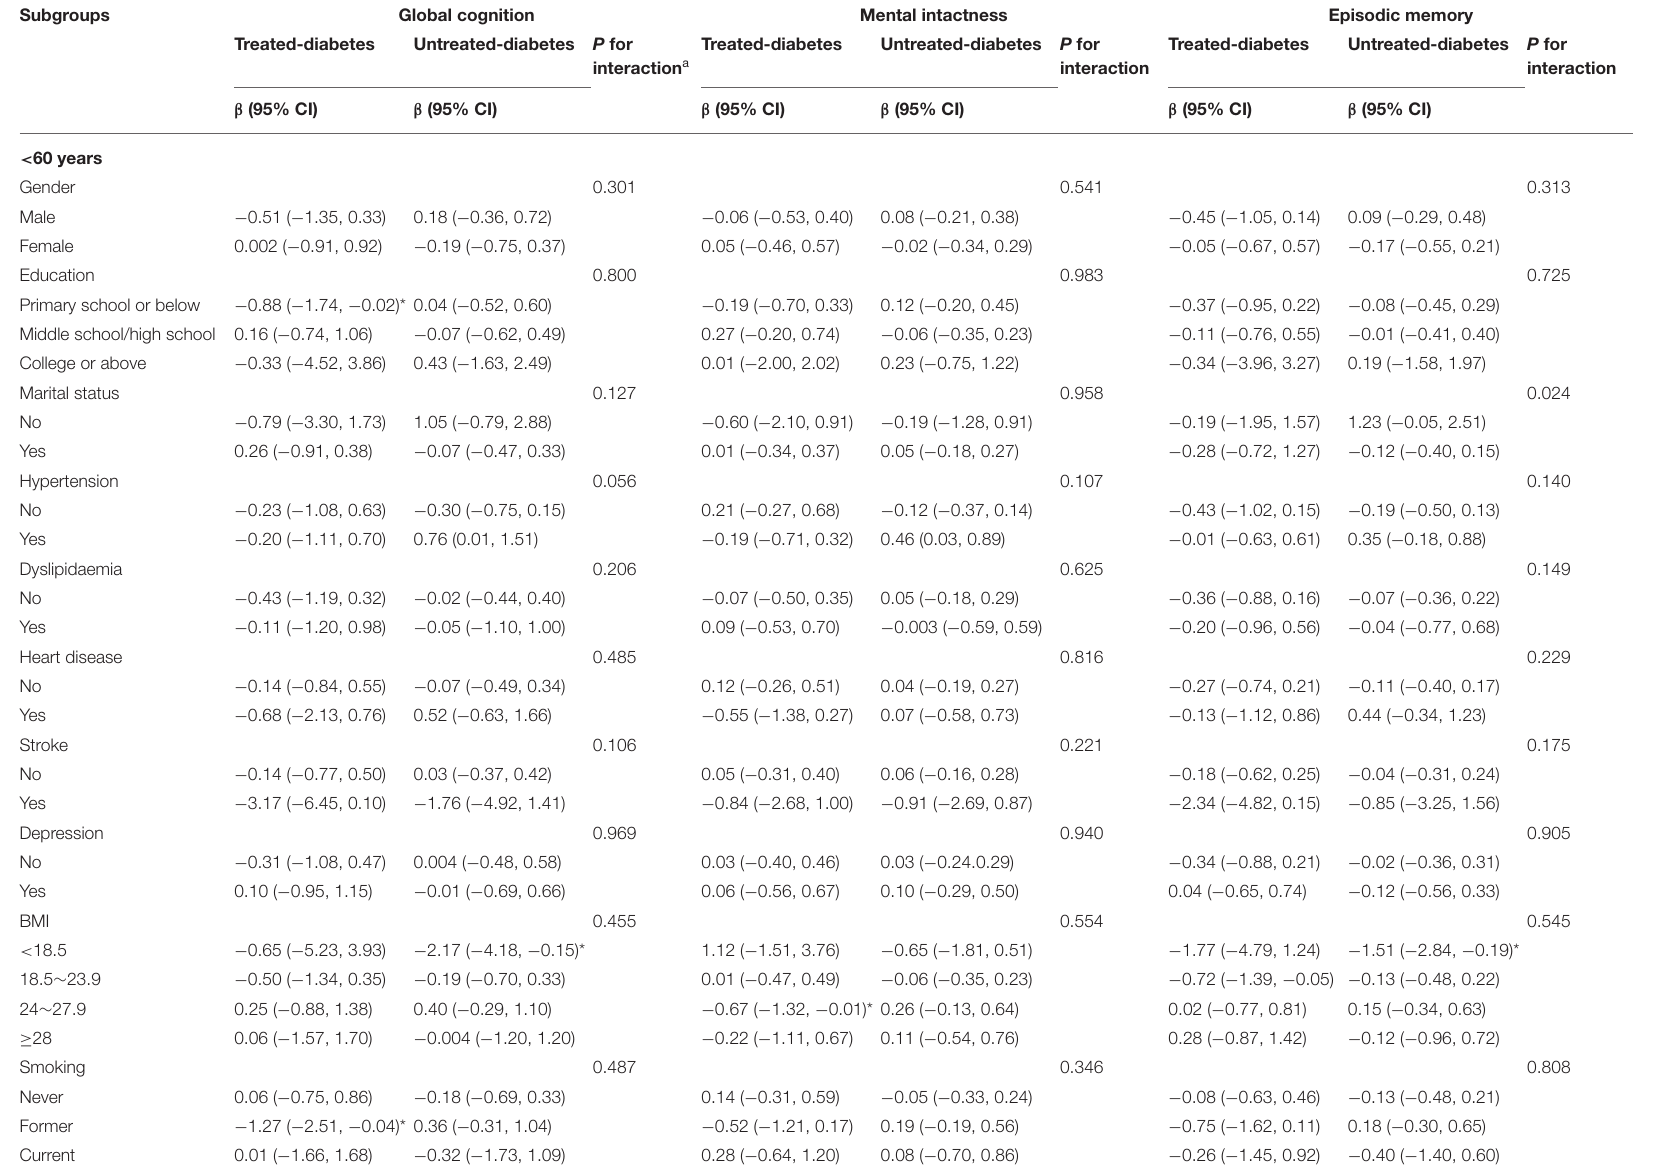
TABLE 3 | Relationships between diabetes status (diabetes-free as the reference group) and cognitive function in the subgroups ( < 60